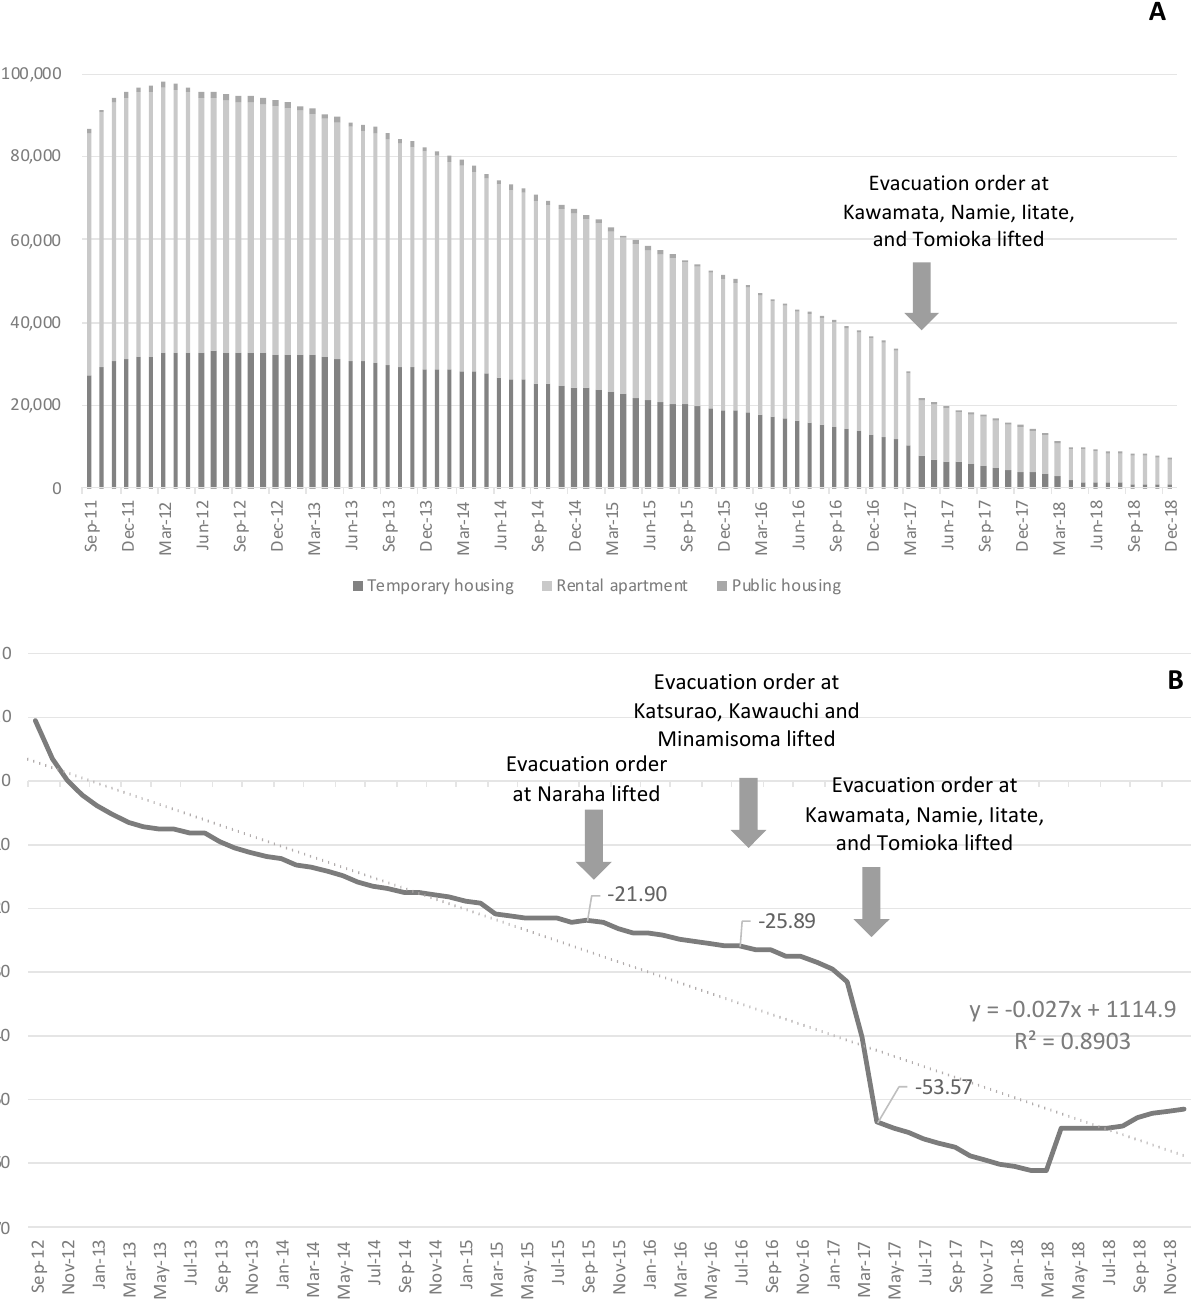
Figure 3. ( A ). Monthly trends of temporary housing residents; ( B ). Monthly trends of temporary housing residents (YoY change, %).